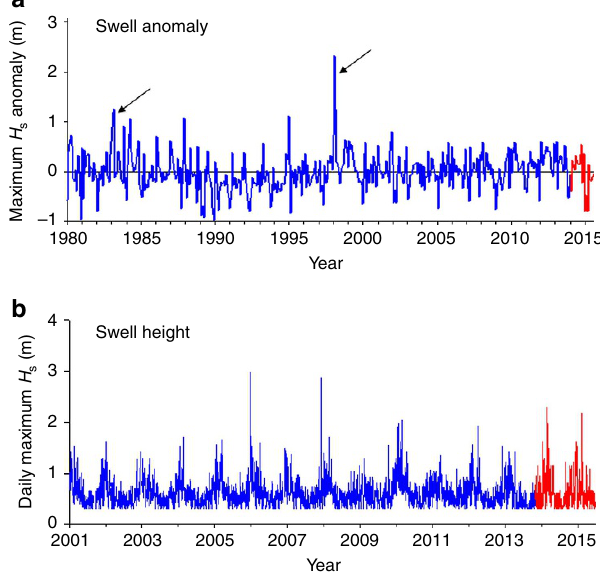
Figure 2 | Swell height data for the Santa Barbara Channel. ( a ) Monthly anomaly in the maximum significant wave height (max H s ) measured from an offshore buoy for the period 1980–2015 and ( b ) Modelled mean daily values of max H s averaged across the nine study sites for the period 2001–2015. The anomalously warm years of 2014–2015 are shown in red. Black arrows in ( a ) denote the 1982–83 and 1997–98 El